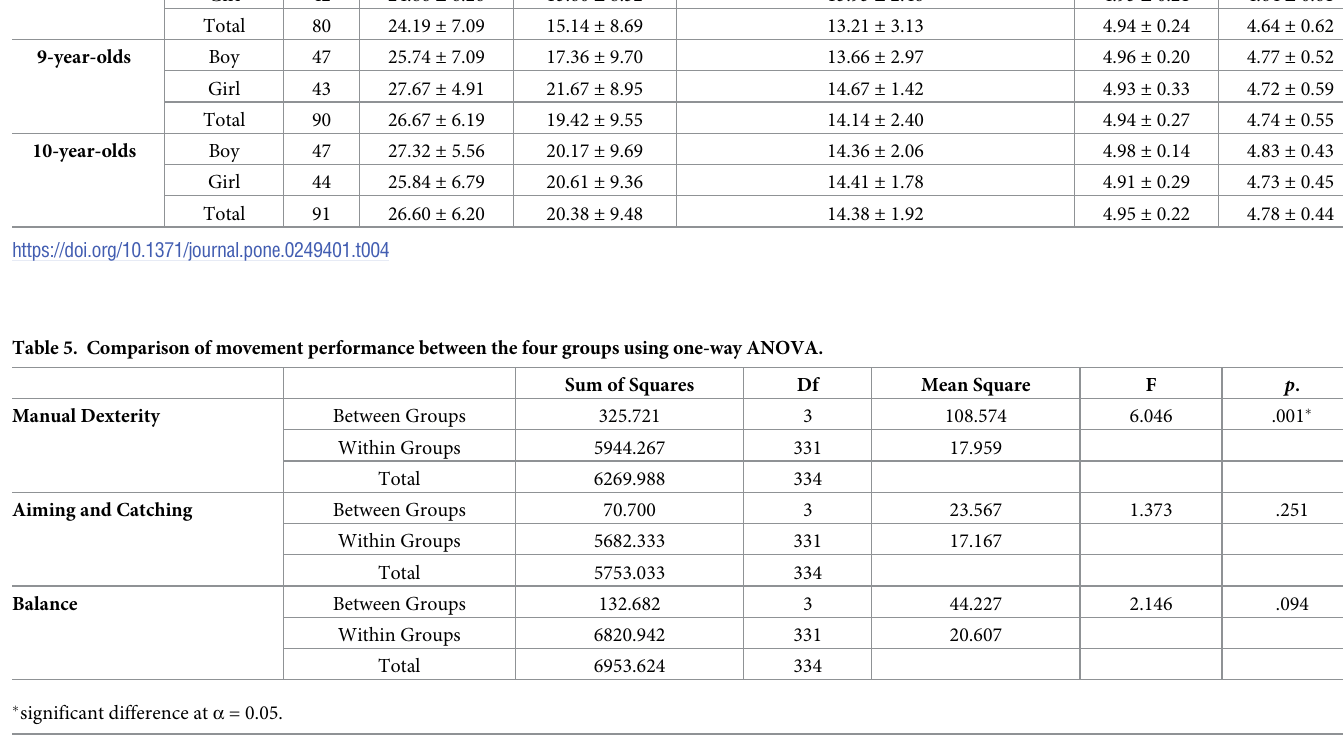
Aiming and Catching